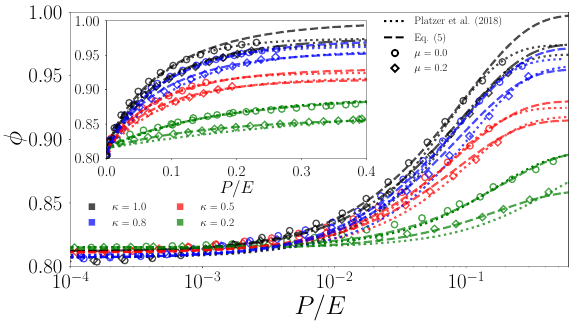
Figure 1. Views for a mixture ratio κ = 0 . 5 and di ff erent reduced pressure P / E with µ = 0 . 2. The inset shows the finite element mesh used. The rigid particles are colored in grey. Figure 2. Packing fraction φ as a function of P / E for mixtures of κ ∈ [0 . 2 ,..., 1] and µ ∈ { 0 , 0 . 2 } . The predictions given by the micro-mechanical equation (Eq. (5)) and the ones given by the Platzer et al. model are also shown.